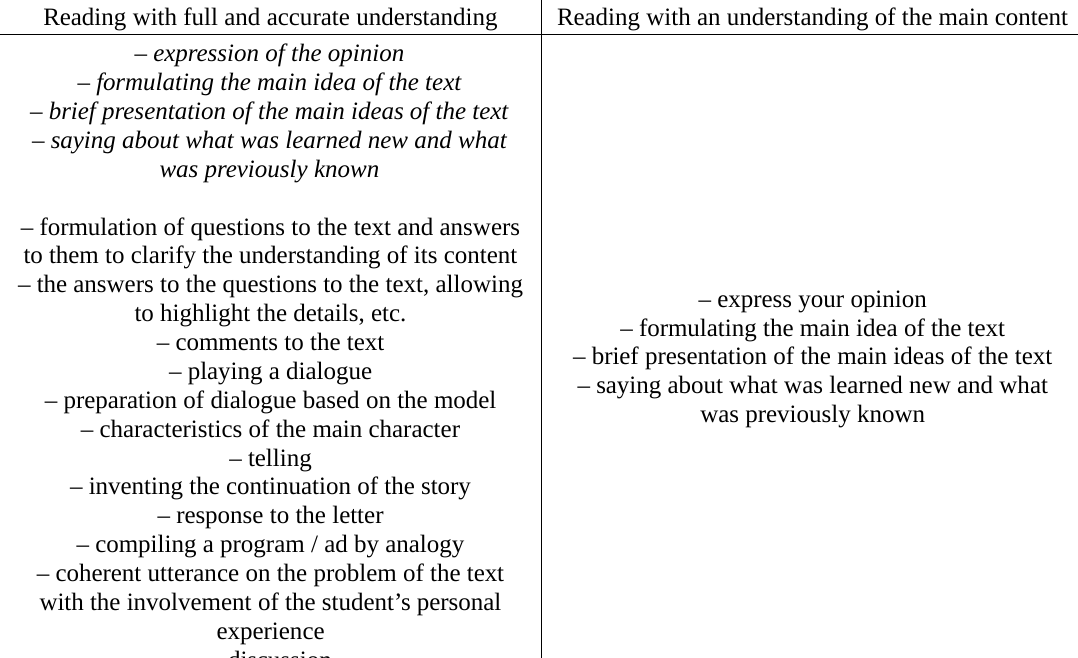
Table 2 - Types of Reading as the Basis for the Development of a